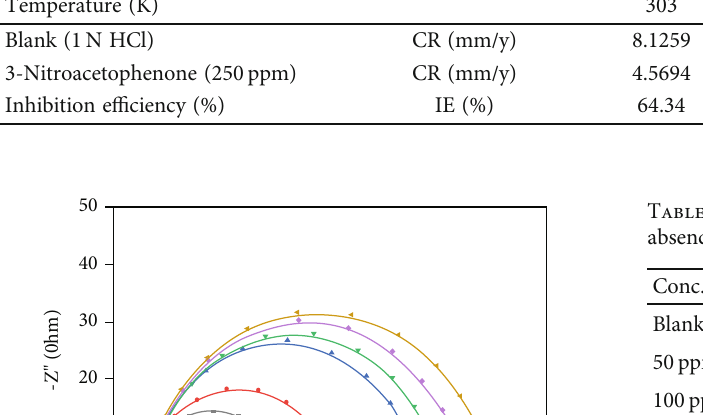
Table 2: Corrosion rate and inhibition e ffi ciency obtained from weight loss measurements for MS specimen at di ff erent temperatures in the absence and presence of 250 ppm concentration of 3-NA inhibitor in an acidic medium (1N HCl). Temperature (K)